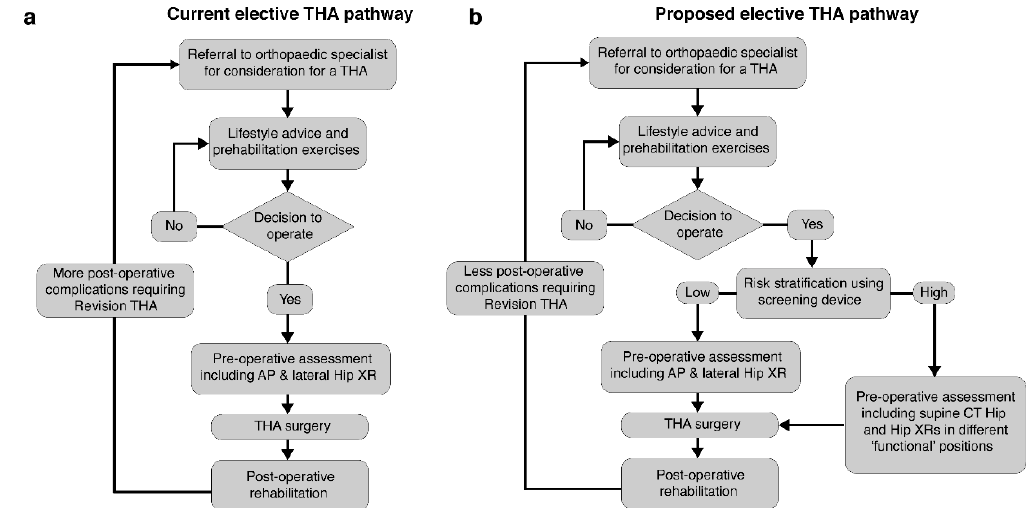
Figure 7. The typical current elective total hip arthroplasty (THA) pathway is shown in ( a ). We propose a revised pathway to include the rapid screening using the device ( b ). Patients